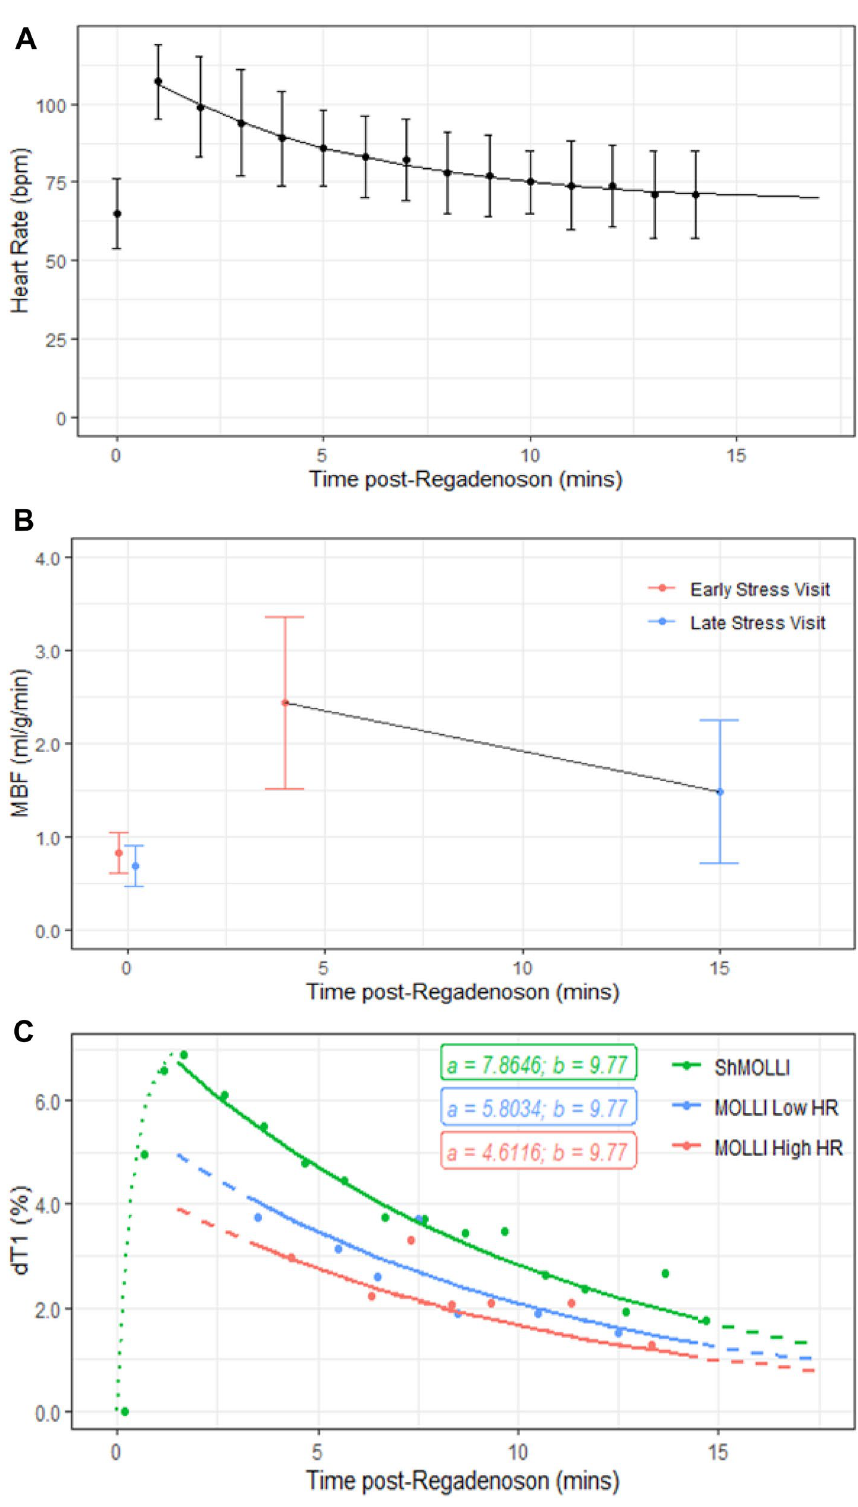
Figure 3. Regadenoson stress effects on heart rate ( A ), MBF ( B ) and dT1 ( C ) with overlaid mono-exponential decay models y = a ∗ exp ( − x / b ) . In panel ( B ), time point 0 corresponds to the baseline conditions and is included to illustrate MBF at rest. In panel ( C ) the decay time b has been established for ShMOLLI only, and only amplitudes scaled to best fit other MOLLI variants; the dashed lines mark the extrapolation of the MOLLI models beyond the respective data ranges. The rising part of the T1 response to stress (dotted green line), HR and MBF responses (fitted to relative changes and transposed) are to guide the eye